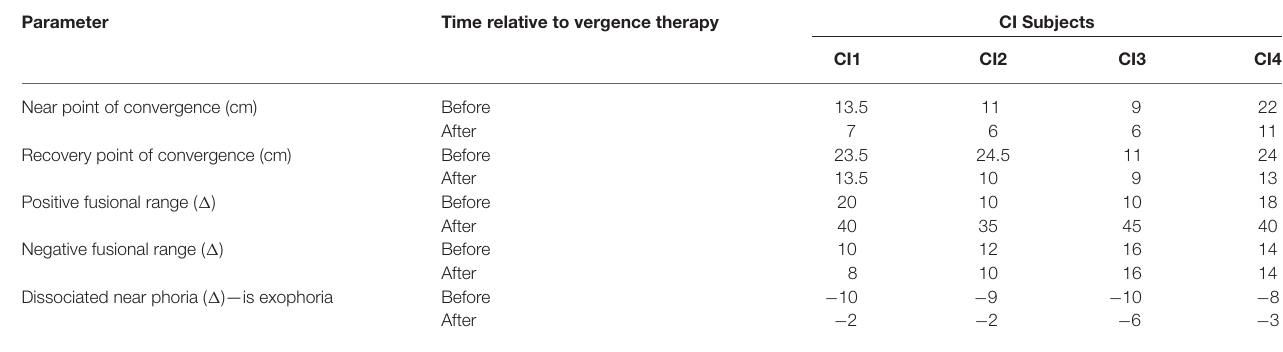
TABLE 1 | Clinical parameters from the CI subjects before and after vergence therapy for near point of convergence (NPC), recovery point of convergence (RPC), positive (base out) and negative (base in) fusional range, and dissociated near phoria. Parameter Time relative to vergence